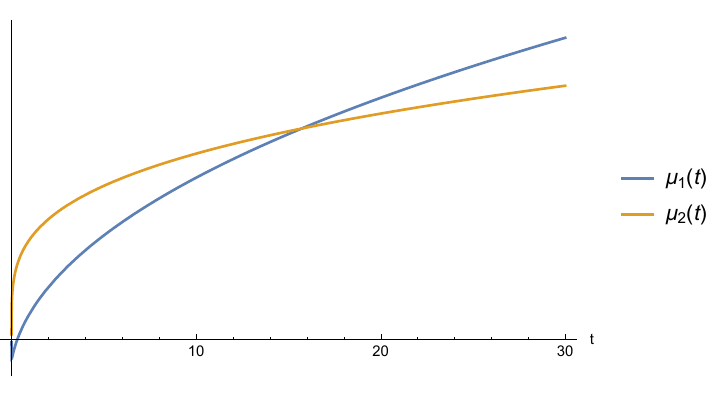
Fig. 7 The solutions of the initial value problem 40–41 for α = 0 . 2